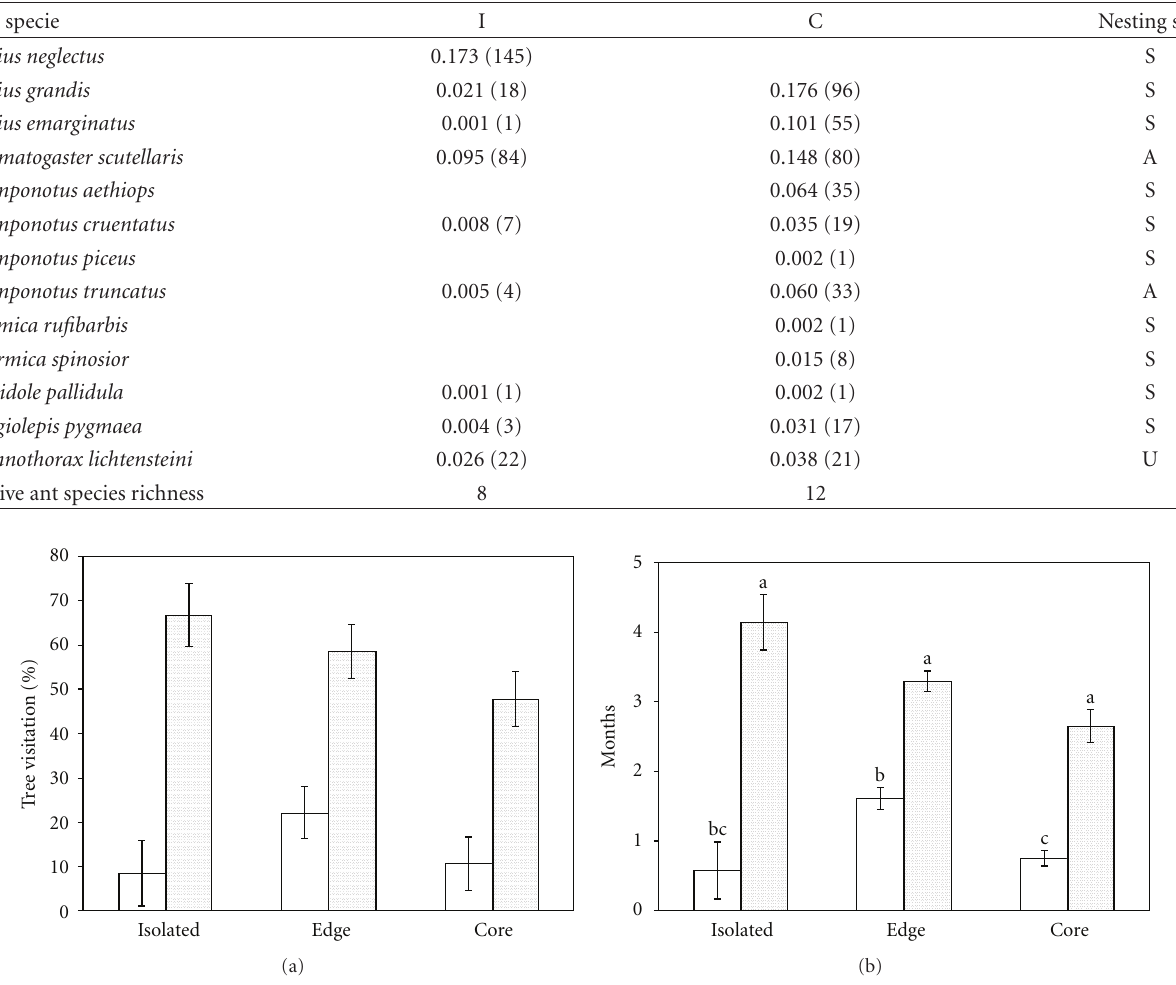
Figure 2: Foraging activity of native ants on trees is shown as the percentage (mean ± SE) of visited trees (a) and the months they remain visited (b) per tree category in 2006 at invaded fragments (bars in white) or at control fragments (dotted bars). Di ff erent letters showed statistical di ff erences of the tree category x ant type interaction ( P < 0 .